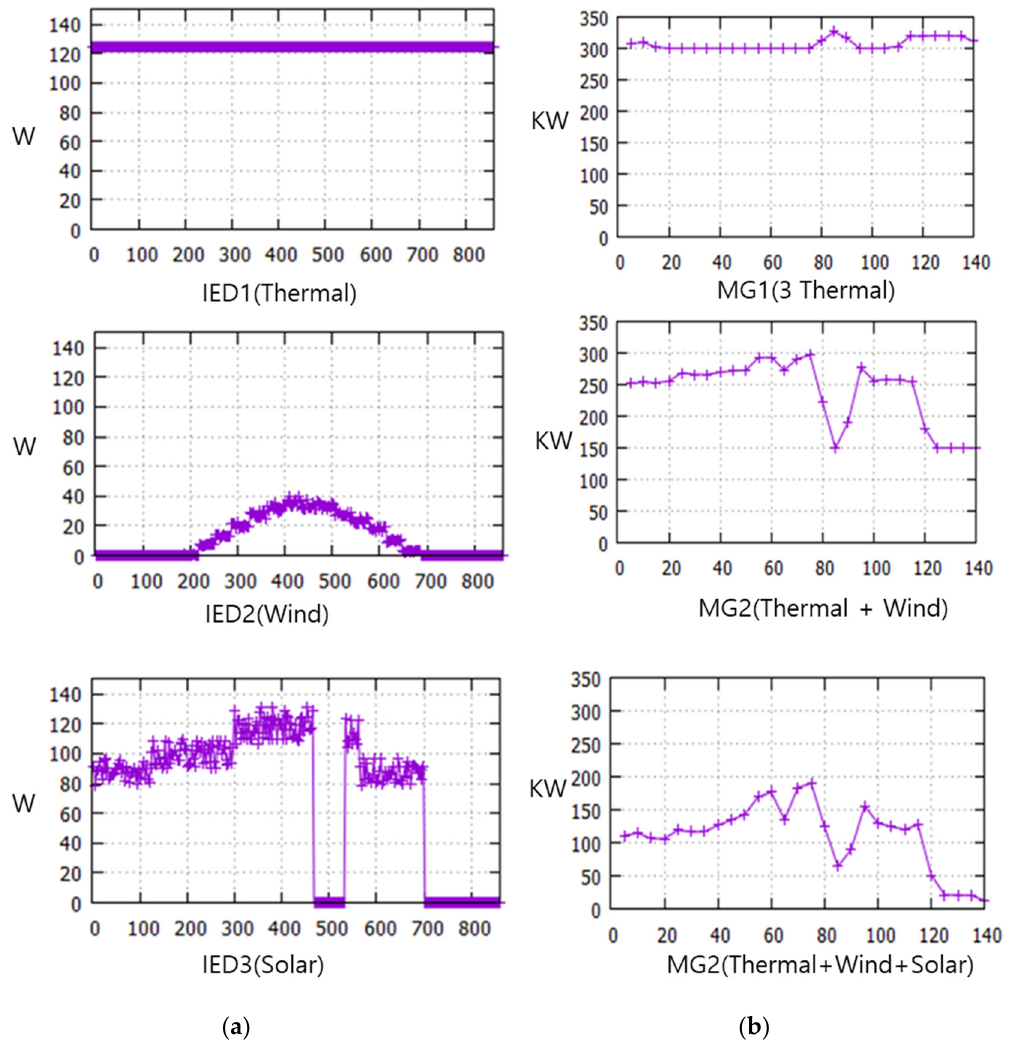
Figure 7. Cluster microgrid monitoring with web service: ( a ) IED surveillance system; ( b ) MG monitoring systems.